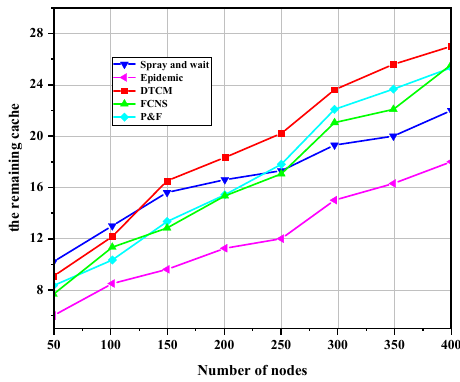
Figure 5. The remaining cache comparison between five algorithms with various number of nodes.